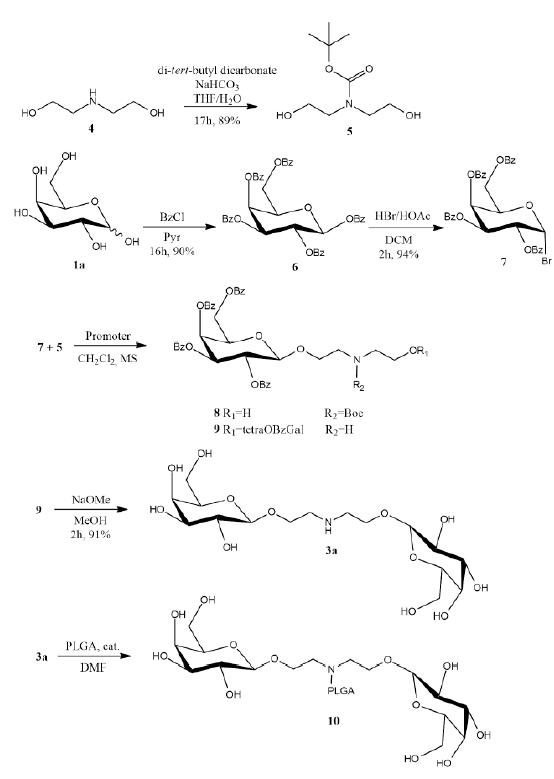
Scheme 1. Synthetic strategy to prepare ligand 3a and PLGA-di-GAL , 10 . Promoter = Ag 2 CO 3 or Ag 2 SO 4 ; catalyst = montmorillonite K10 or methanesulfonic acid.